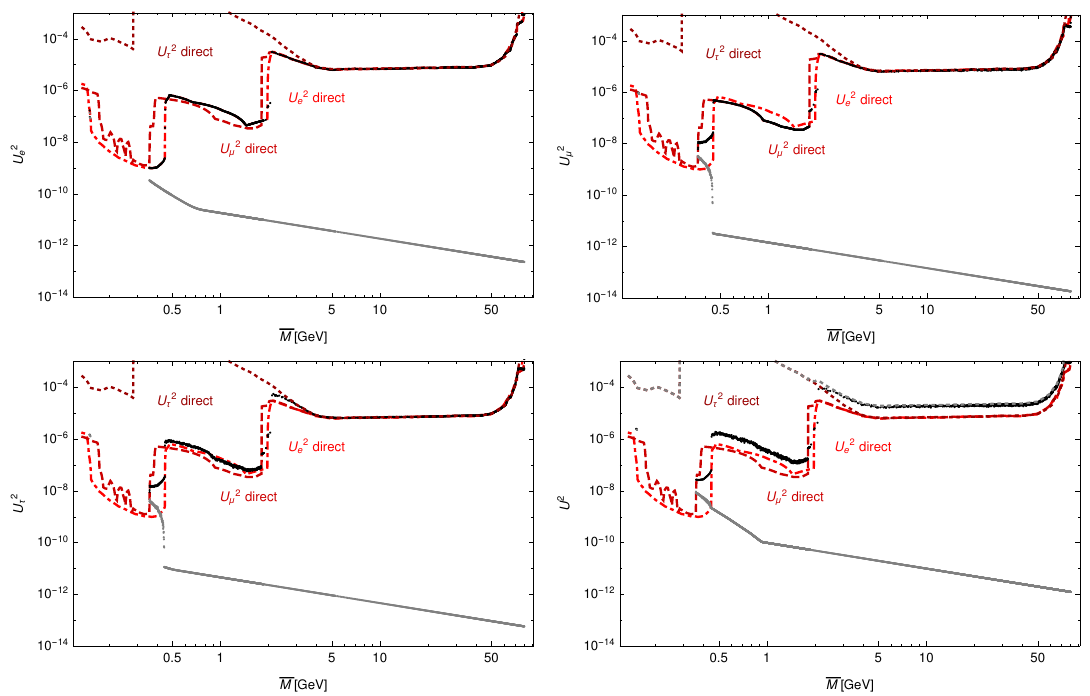
Figure 3 . Global constraints from direct and indirect search experiments and BBN for inverted hierarchy and (cid:1) M < 10 MeV. The black and grey dots mark the largest and smallest value of U 2 and U 2 we found to be consistent with all constraints in each mass bin. For comparison, the red lines show the direct search constraints from collider and (cid:12)xed target experiments on U 2 dotted), U 2 (dashed) and U 2 (dotted) alone. In the plot for U 2 we also added their sum as dashed (cid:22) (cid:28) grey